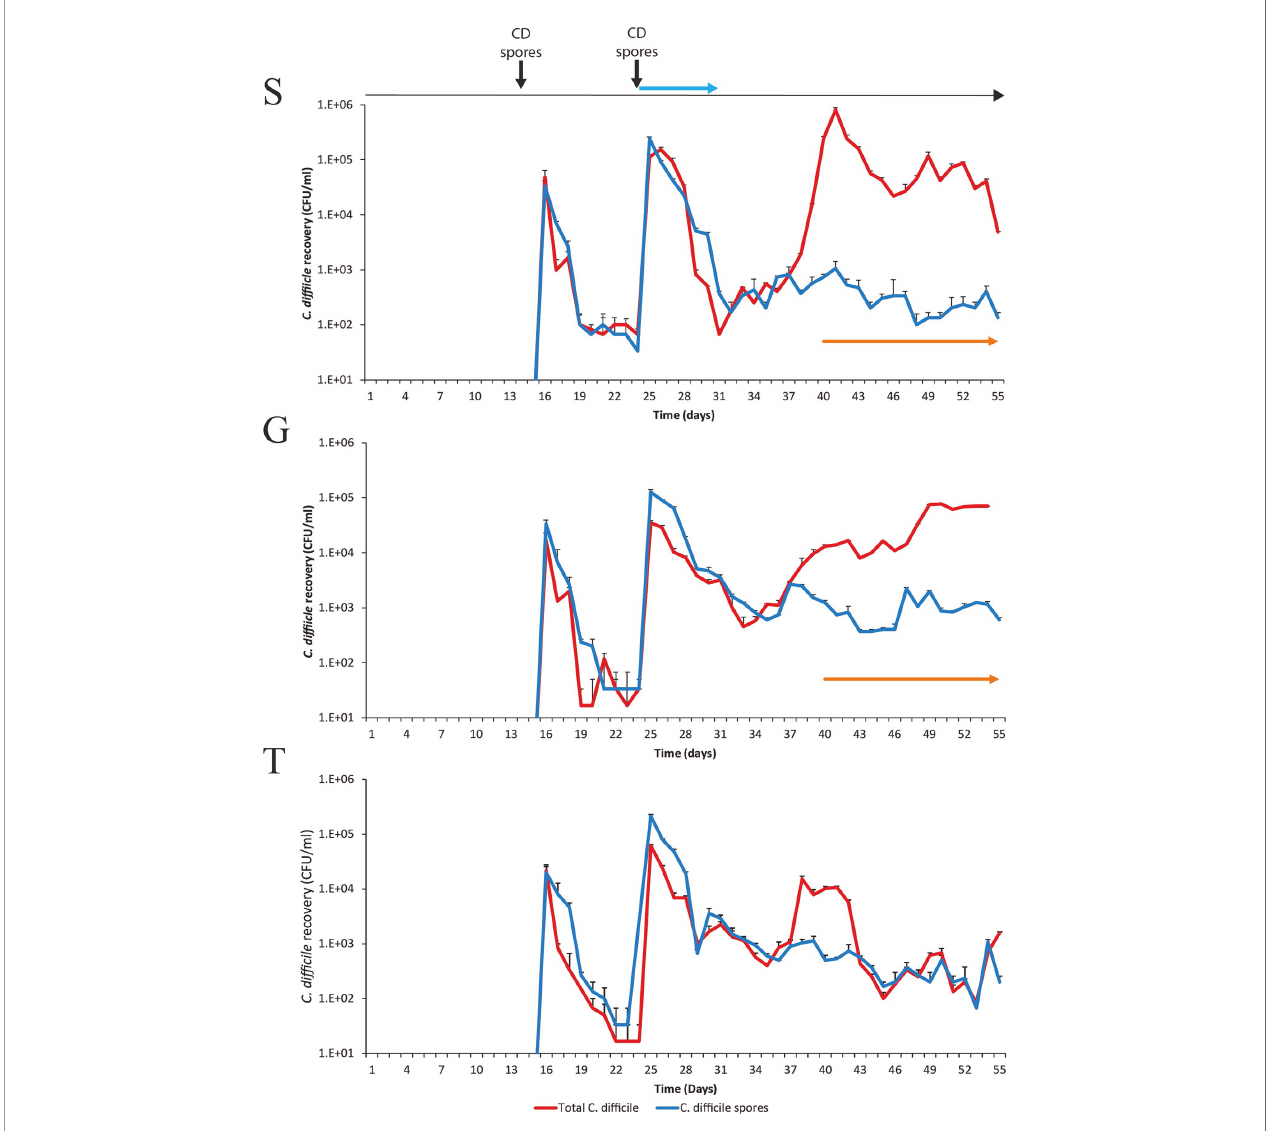
FIGURE 5 | Recovery of C. dif fi cile from model S, (S) , model G, (G) and model T (T) . Recovery of the total C. dif fi cile populations (red lines) and the spore populations (blue lines) from vessel 3 are shown for each model. Spore germination and outgrowth was determined by a divergence between the red and blue lines. The detection of toxin is represented by orange arrows; there is no orange arrow for model T as no toxin was detected. Results expressed as mean ± SD from three technical replicates. CD spores denotes when the C. dif fi cile spores were inoculated into the model. Blue arrow denotes when clindamycin was instilled into the